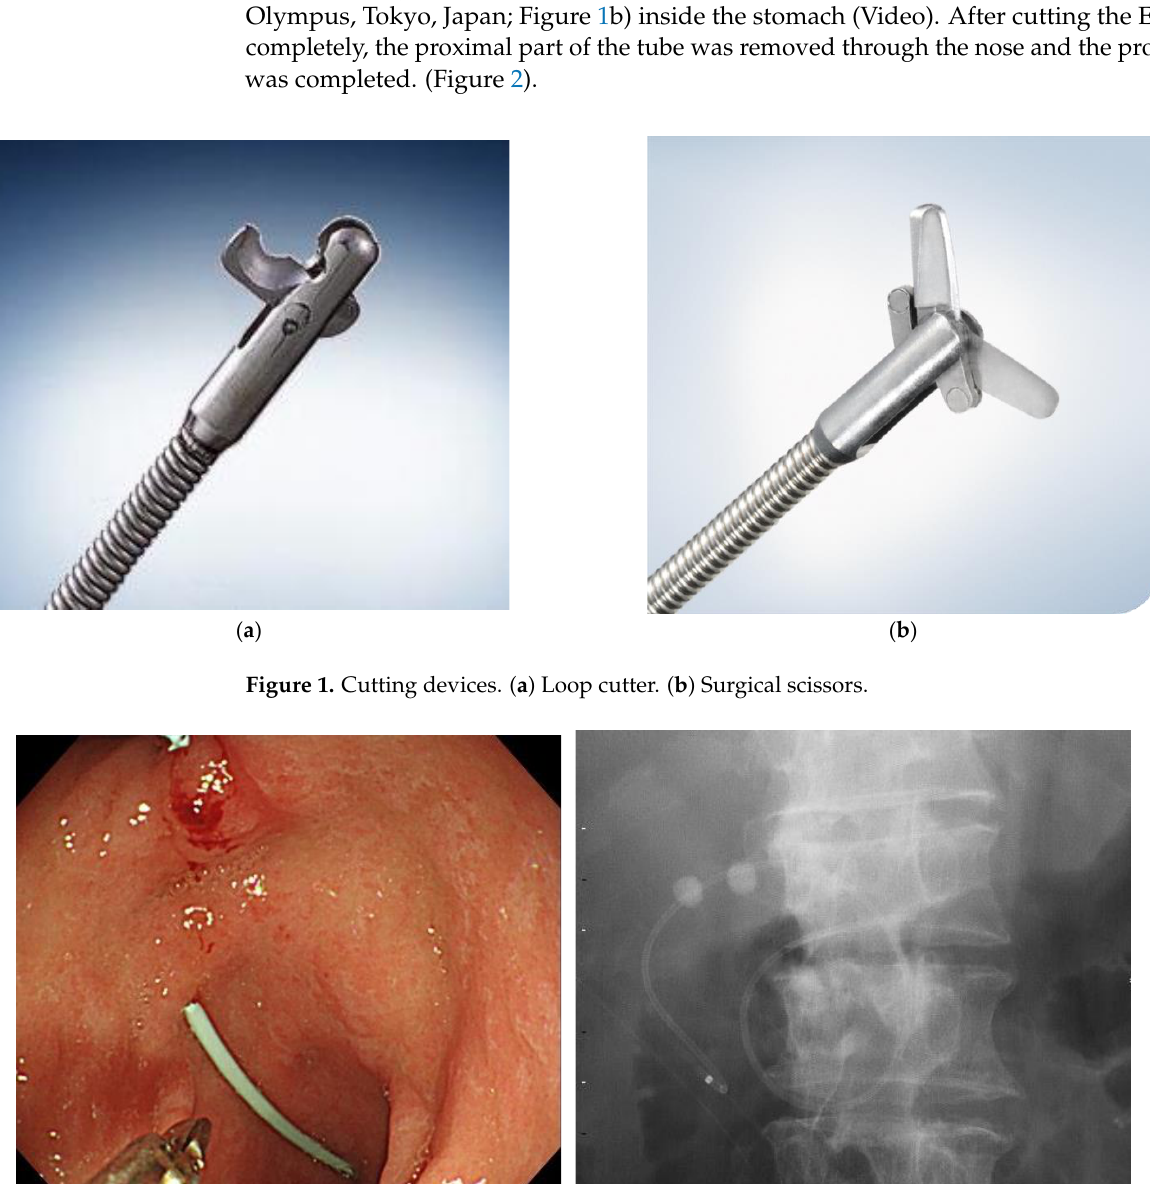
Figure 2. EGBS after internalization by cutting the ENGBD tube. ( a ): Endoscopic image. ( b ): Fluor- oscopy image. EGBS, endoscopic gallbladder stenting; ENGBD, endoscopic nasogallbladder drain- age.